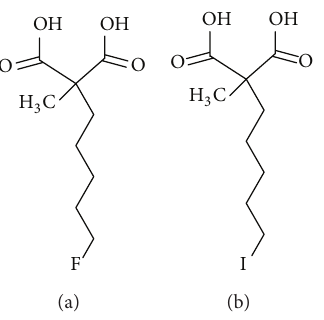
Figure 4: Structures of (a) 18 F-ML-10 and (b) 123 I-ML-10.